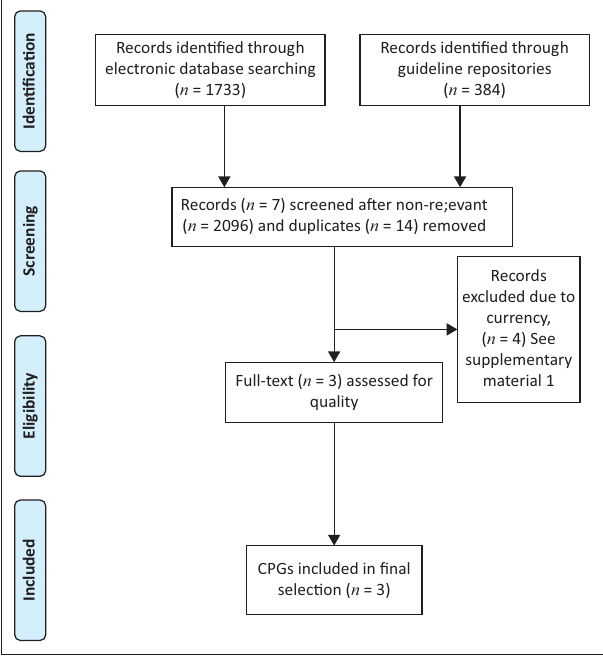
FIGURE 1: PRISMA flow